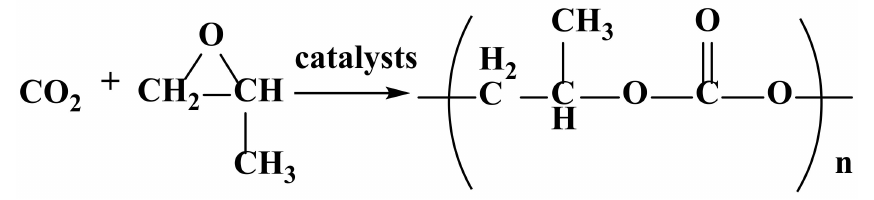
Figure 2. Synthetic reaction of PPC